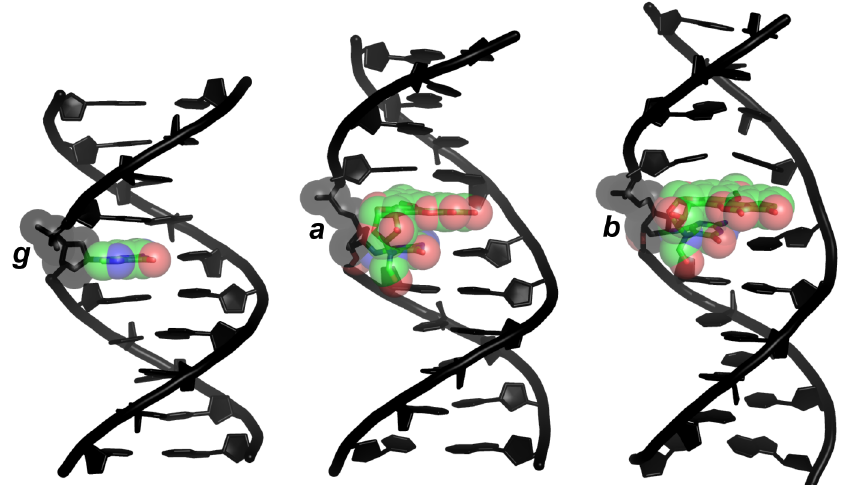
Figure 2. Structures of dsDNA decamers differing in the nucleobase 5. ( g ), Gua (standard B-DNA model); ( a ), α -FAPy-N7-9-hydroxy-AFB 1 (NMR structure; PDB ID 2KH3); ( b ), β -FAPy-N7-9-hydroxy-AFB 1 (NMR structure; PDB ID 1HM1). Green, carbon; blue, nitrogen; red,